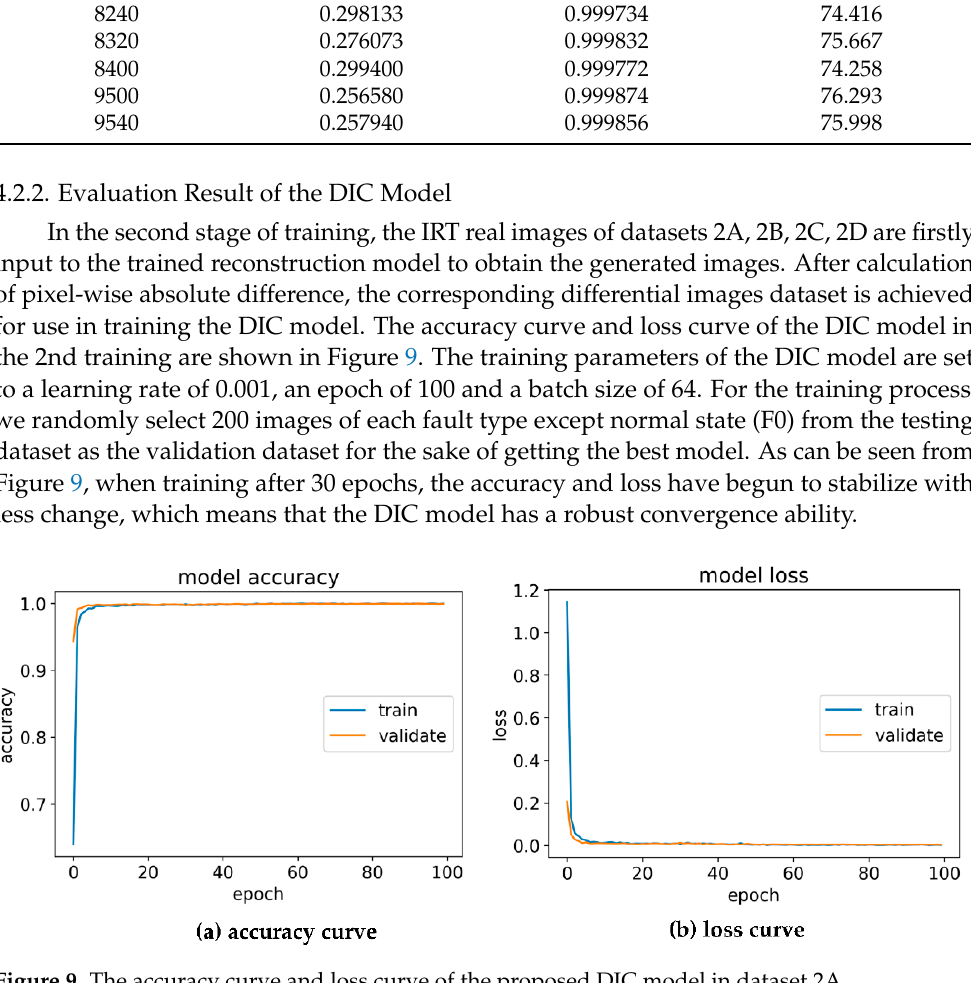
Table 7. The testing result of the proposed WAR-DIC model in different imbalance training da- tasets.